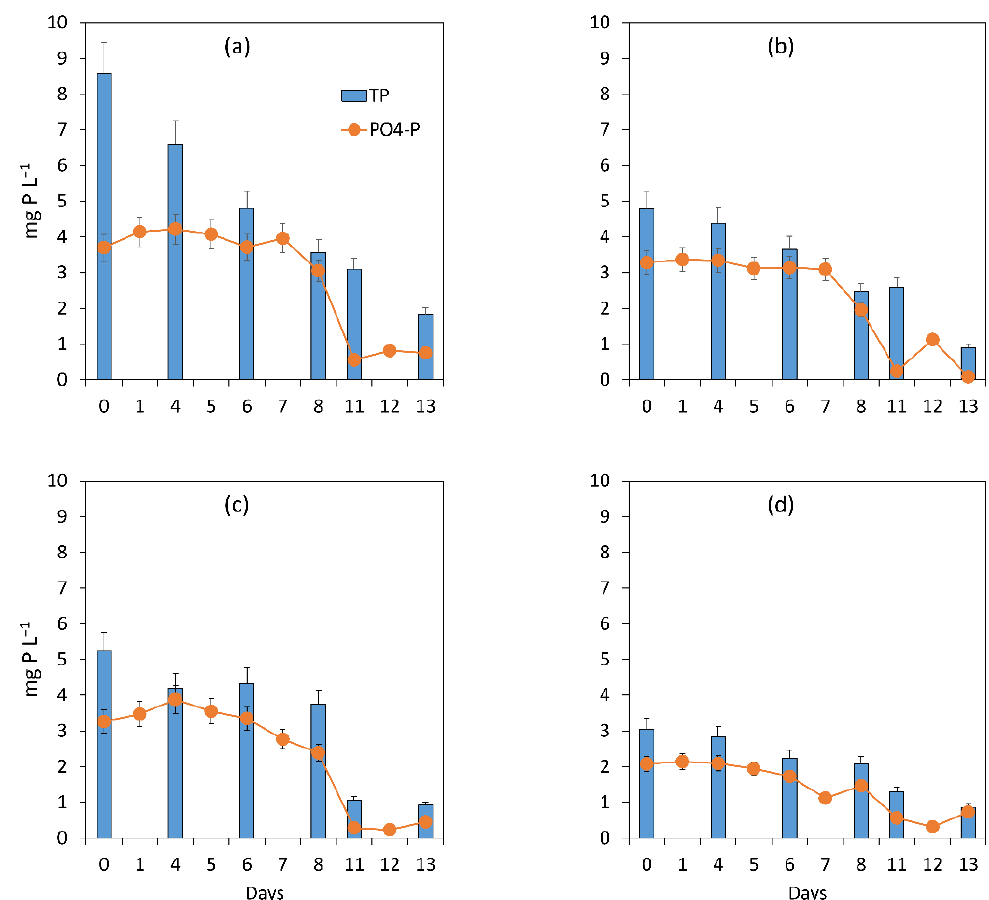
Figure 3. Concentration of TP and PO 43 − -P in the reactors under the impacts of light and nutrient load. ( a ) HL.X5, ( b ) HL.X10, ( c ) LL.X5 and ( d ) LL.X10.